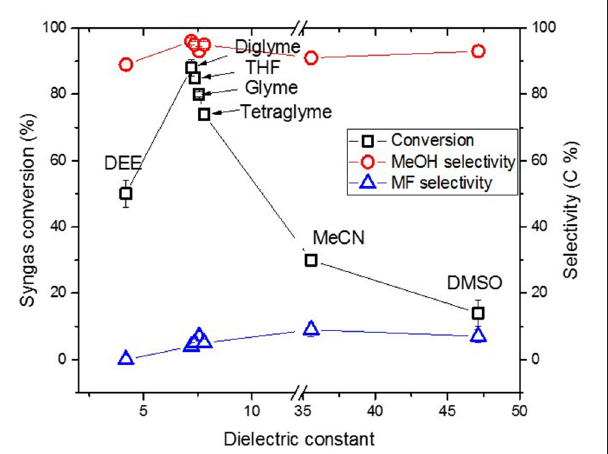
FIGURE 10 | Syngas conversion and selectivity versus dielectric constant of solvent in the CuO/SiO 2 catalyzed